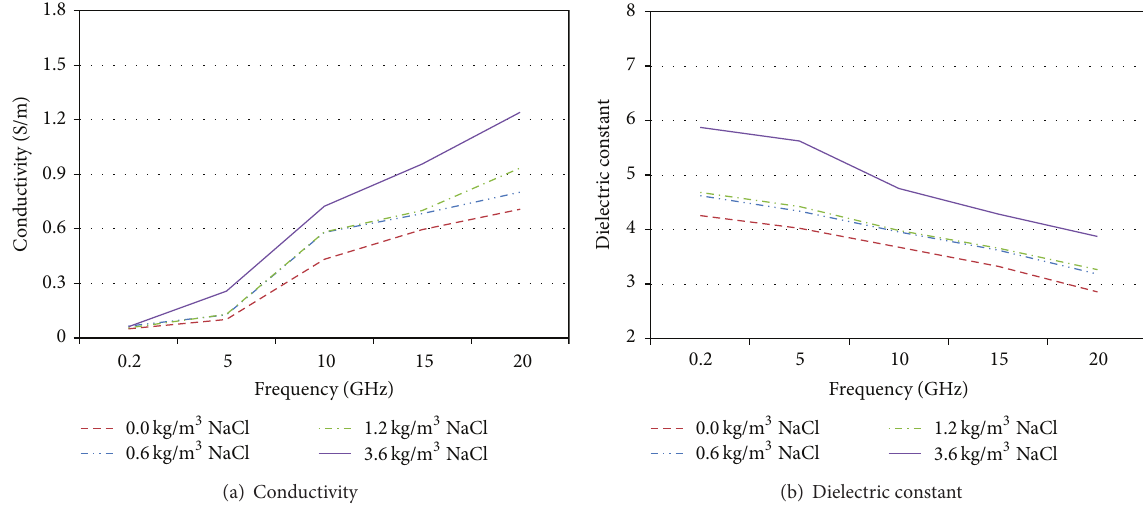
Figure 5: Conductivity and dielectric constant (w/c 0.65).